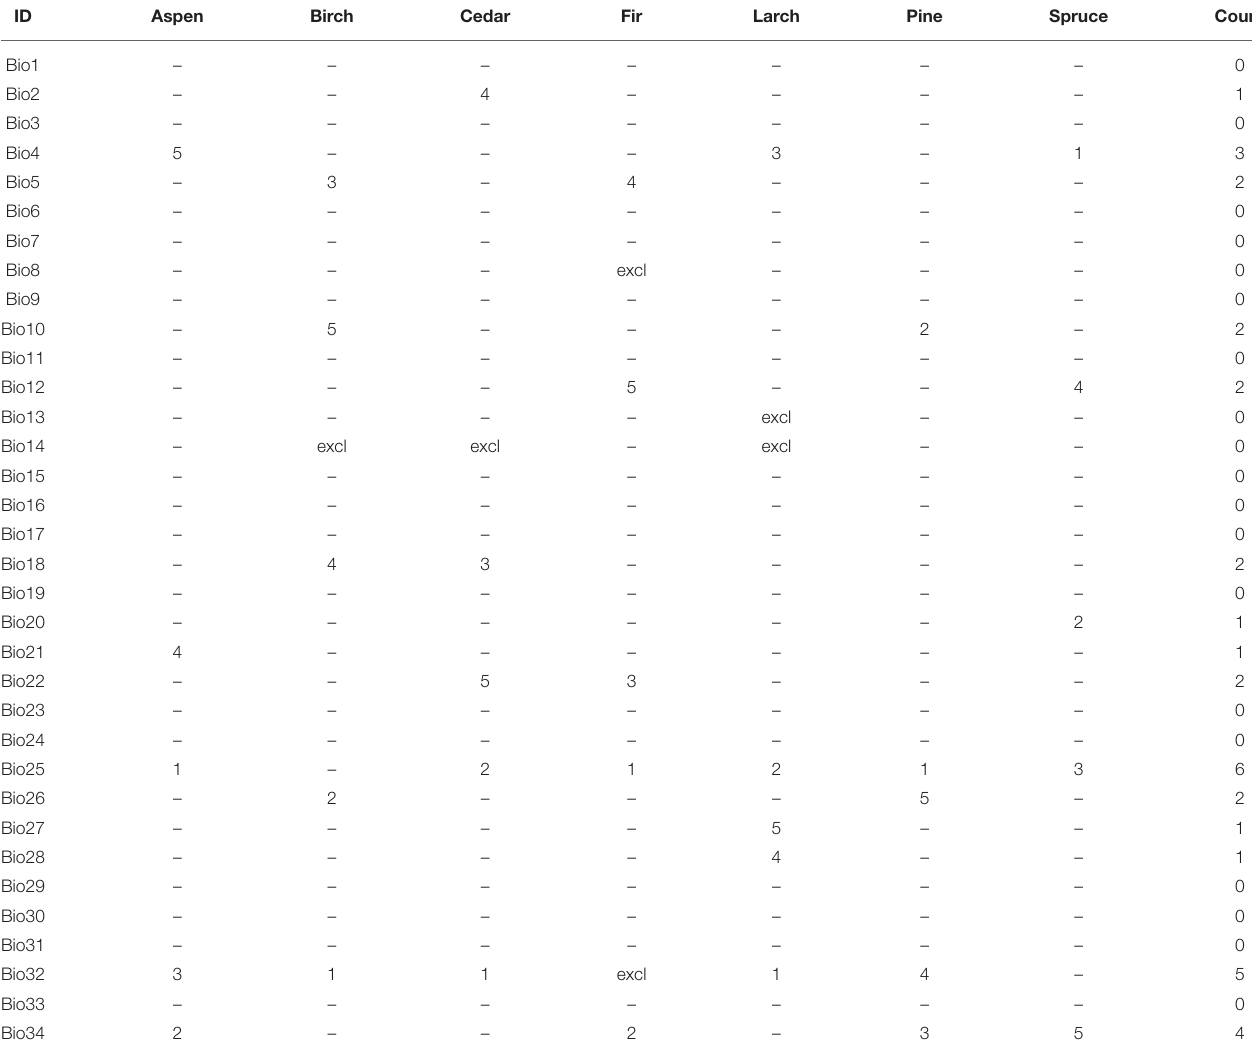
TABLE 6 | The five most important and excluded environmental (bioclimatic) predictors according to BIOMOD2 calibration for each